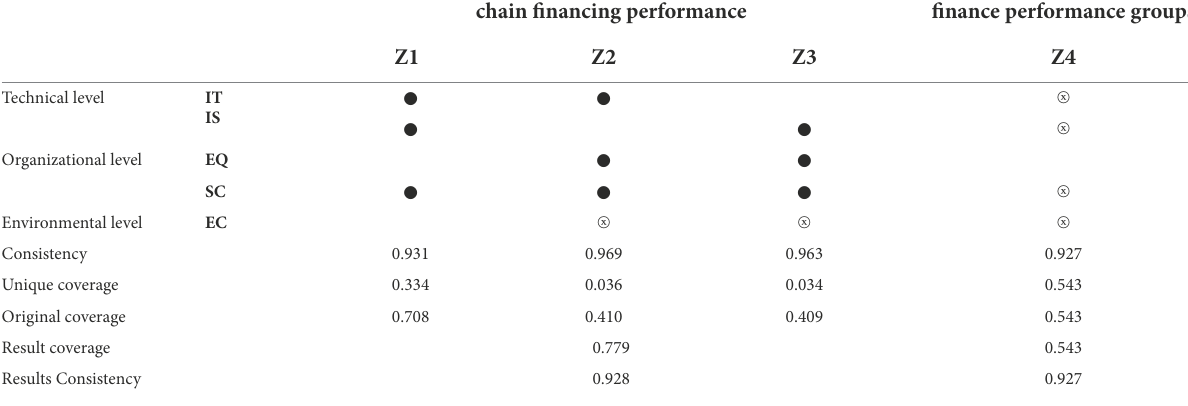
TABLE 5 Group analysis of high and low supply chain financing performance. Variable